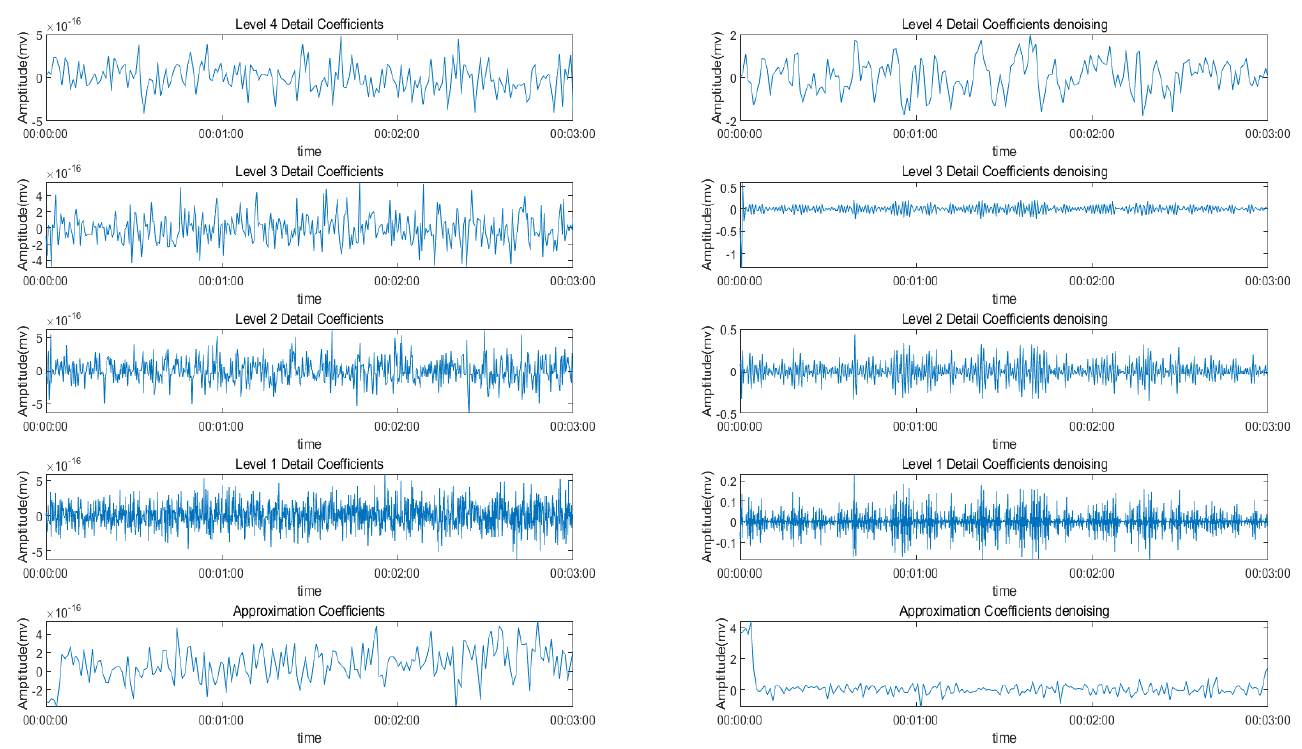
Figure 6. The wavelet decomposition coefficient feature vectors at different levels.